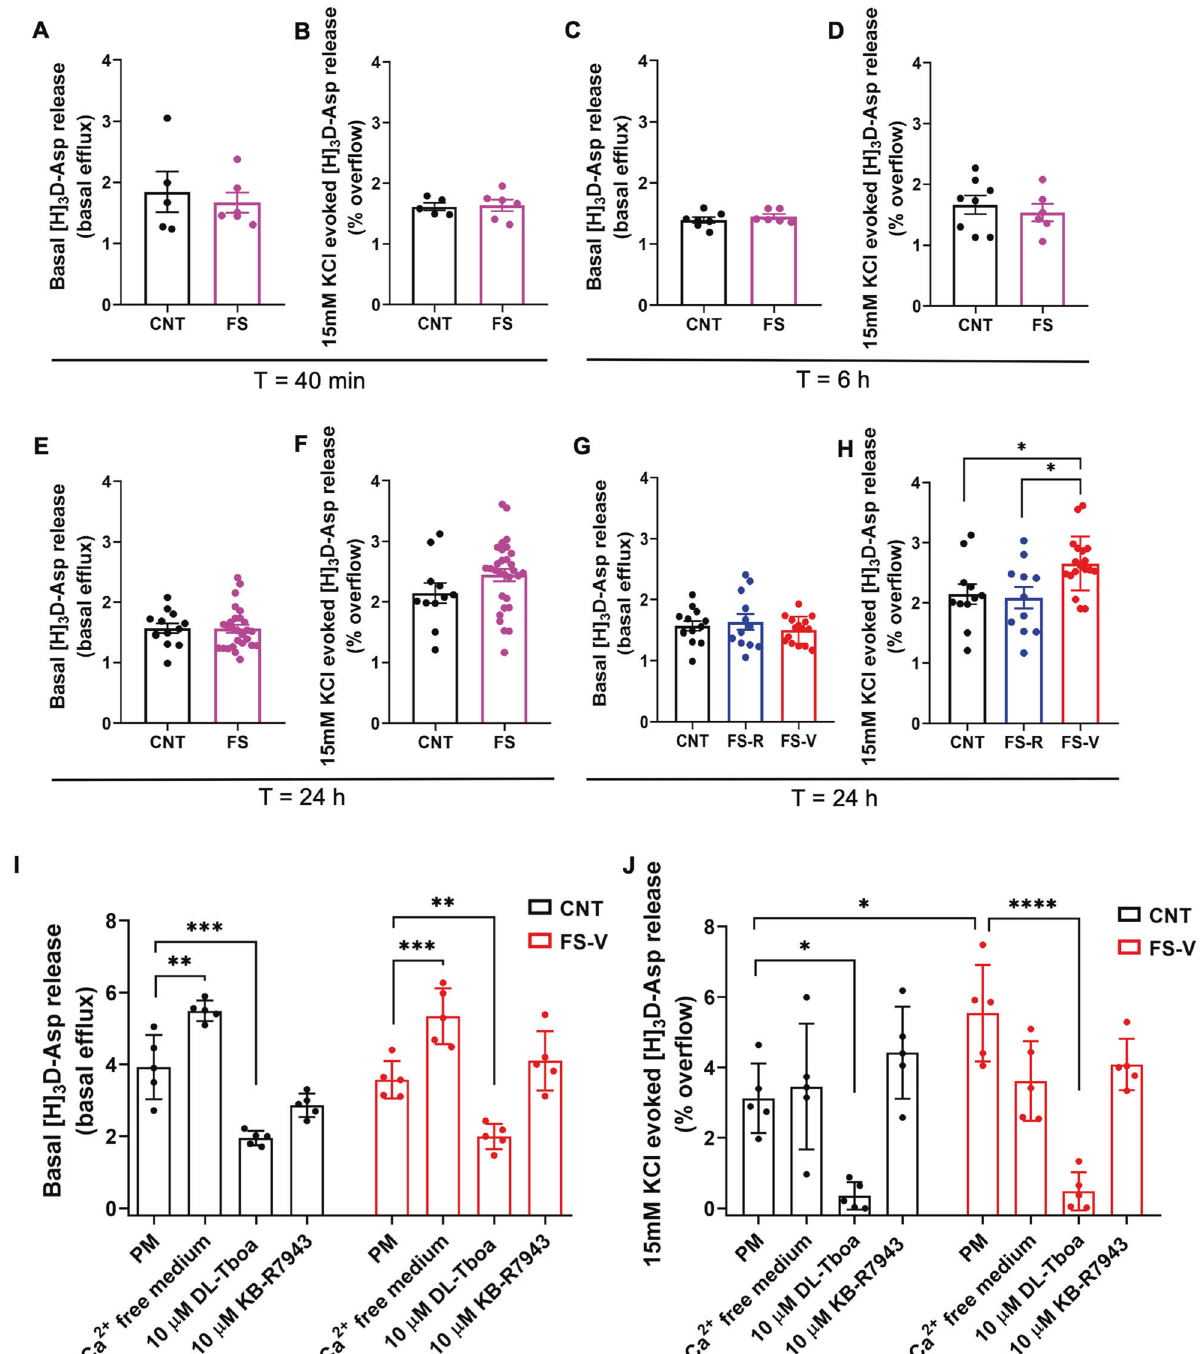
Fig. 5 Glutamate release from PFC gliosomes. A Basal and ( B ) 15 mM KCl-evoked [ 3 H]-Asp release measured immediately after FS (40 min from the beginning of stress). Unpaired student ’ s t -test; N = 5 (CNT), 6 (FS). C Basal and ( D ) 15 mM KCl-evoked [ 3 H]-Asp release measured 6 h after the beginning of FS. Unpaired student ’ s t -test; N = 8 (CNT), 6 (FS). E Basal and ( F ) 15 mM KCl-evoked [ 3 H]-Asp release measured 24 h after the beginning of FS. Unpaired student ’ s t -test; N = 11 (CNT), 30 (FS). G Basal and ( H ) 15 mM KCl-evoked [ 3 H]-Asp release measured 24 h after the beginning of FS with separation in FS-R and FS-V. One-way ANOVA, Tukey ’ s post-hoc test: p < 0.05. N = 11 (CNT), 11 (FS-R), 19 (FS-V), * p < 0.05. I Basal and ( J ) 15 mM KCl-evoked [ 3 H]-Asp release measured in physiological conditions (physiological medium, PM) or in presence of calcium free medium, 10 µM DL-TBOA or 10 µM KB-R7943 24 h after the beginning of FS in CNT and FS-V. Two-way ANOVA, Tukey ’ s post-hoc test: p < 0.05. N = 5 (CNT), 5 (FS-V), * p < 0.05, ** p < 0.01, *** p < 0.001 and **** p < 0.0001. subunit in the PFC and reduced apical dendritic length and rats, while depolarization-evoked glutamate release and complexity of prelimbic PFC layers II – III pyramidal neurons synapsin I phosphorylation at Ser 9 increased in both FS-R and (both FS-R and FS-V); FS-V animals; BDNF expression selectively diminished in the PFC of FS-V rats; FS decreased the synaptic expression levels of the GluN2A